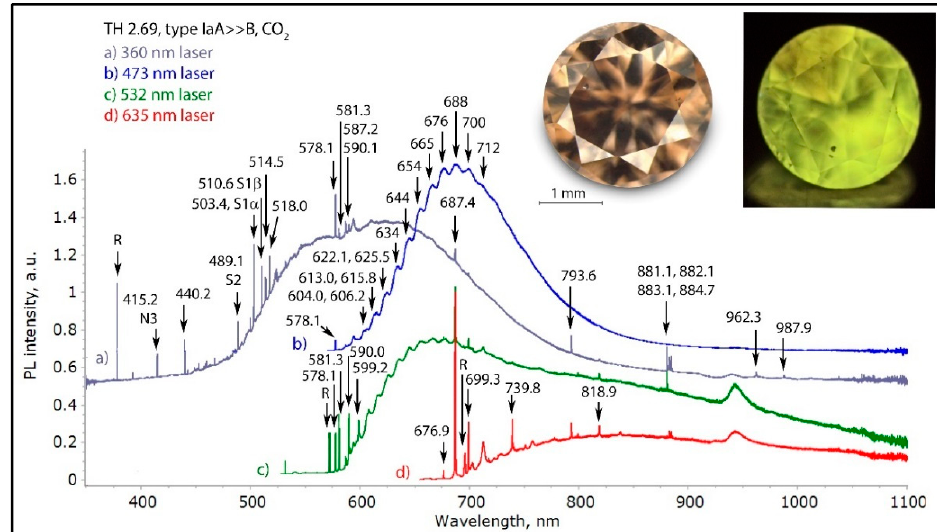
Figure 8. The highly complex PL spectra of a CO 2 diamond (TH 2.69) under four different laser excitations. The yellow PL seen in the photo is caused by the S1 and S2 defect. The complex band centered at about 690 nm with all its oscillating peaks separated by 10 to 12 nm each seen in trace ( b ) is very typical for diamonds rich in oxygen, and it relates directly to the 480 nm absorption band. Such diamonds always contain nickel as well, as can be seen by the presence of S1 and S2 as well as many of the sharp features seen in the spectra. The spectra have been shifted vertically for clarity.